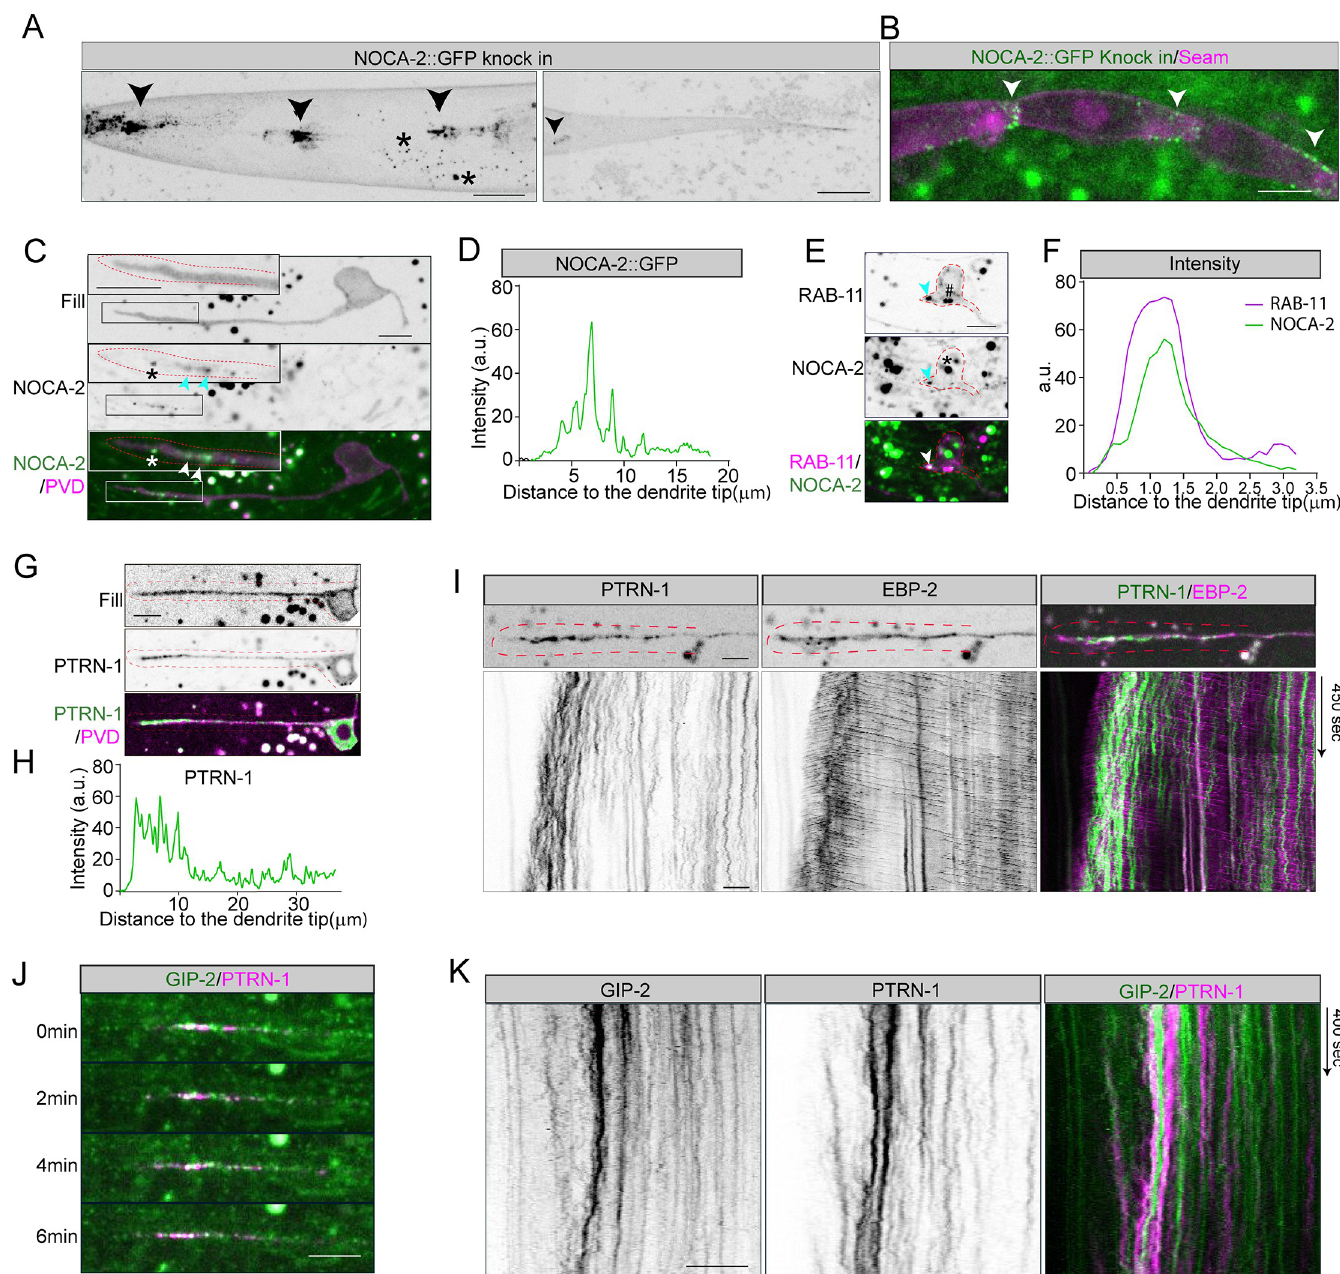
Fig 4. NOCA-2 (NINEIN) localizes to the distal MTOC vesicles. ( A , B ) The localization of endogenously tagged NOCA-2::GFP. NOCA-2 accumulates to structures in the head and tail (marked with arrowheads) ( A ) and to epidermal seam cell junctions (indicated with arrowheads) ( B ). The puncta marked with the � symbol are autofluorescent gut-granules. Scale, 10 μ m. ( C , D ) Endogenous NOCA-2::GFP localization ( C ) and the intensity quantification ( D ) in the PVD neuron during anterior dendrite outgrowth (magenta: neuron fill). NOCA-2 puncta are indicated with arrowheads in ( C ) and shown enlarged in the top left of each panel (the puncta marked with � might be autofluorescent gut-granules). Scale, 5 μ m. The developing anterior PVD dendrites are indicated with red dashed lines. ( E , F ) Colocalization ( E ) and the intensity profile ( F ) of endogenous NOCA-2::GFP (green) and PVD expressed mKate2::RAB-11 (magenta) in the developing PVD neuron. Arrowheads point to the colocalization of RAB-11 and NOCA-2. The puncta marked with � are autofluorescent, and the RAB-11 puncta without obvious NOCA-2 accumulation are marked with # in ( E ). Scale, 5 μ m. The PVD neuron is indicated with red dashed lines. ( G , H ) Representative example ( G ) and intensity profile ( H ) of a PVD neuron expressing GFP::PTRN-1 in the developing dendrite; Fill of PVD (magenta), PTRN-1 puncta (green). Scale, 5 μ m. The anterior PVD dendrite is indicated with red dashed lines. ( I ) PTRN-1 dynamics in the growing PVD anterior dendrites with respect to microtubule nucleation; PTRN-1(green), EBP-2::GFP (magenta). Scale, 5 μ m. The distal anterior PVD dendrites are indicated with red dashed lines. ( J , K ) Cotransport and kymograph of GIP-2::GFP and mKate2::PTRN-1 in the distal segment of the growing PVD anterior dendrite. PTRN-1 (magenta), GIP-2 (green). Scale, 5 μ m.